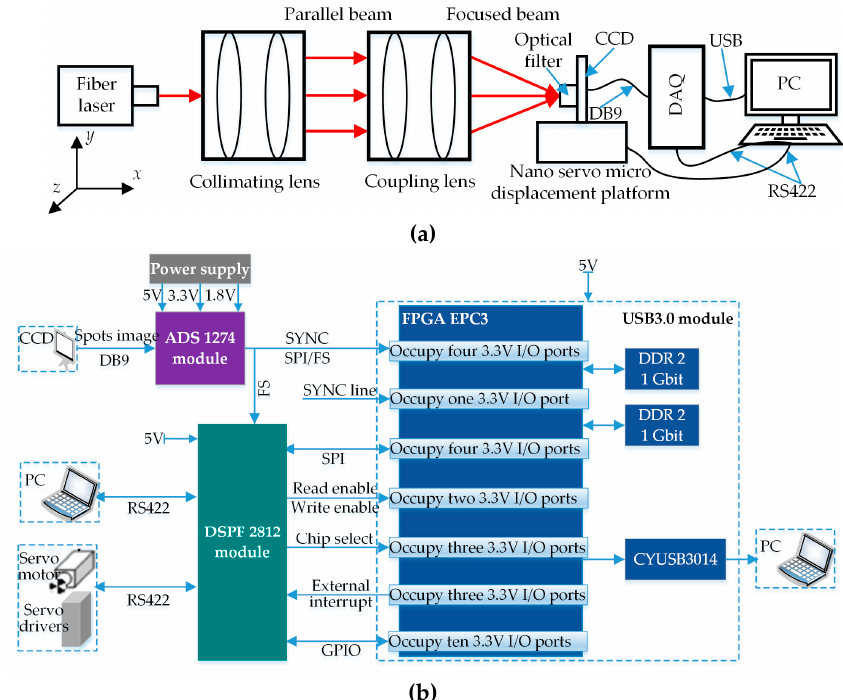
Figure 1. Spot image signal acquisition system. ( a ) Experimental principle schematic diagram. ( b ) Data acquisition (DAQ) board architecture diagram.